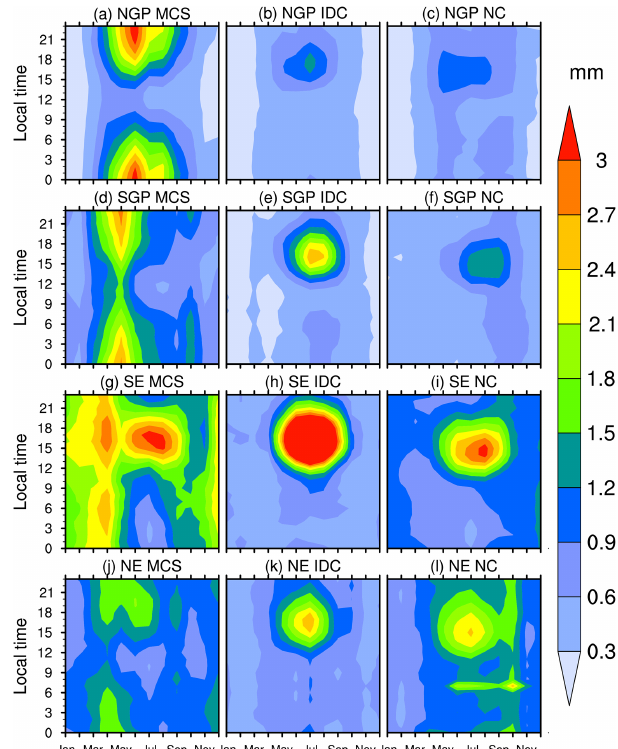
Figure 9. Monthly mean diurnal cycles of precipitation amounts from MCSs (a, d, g, j) , IDC (b, e, h, k) , and NC (c, f, i, l) in the NGP (a, b, c) , SGP (d, e, f) , SE (g, h, i) , and NE (j, k, l) during